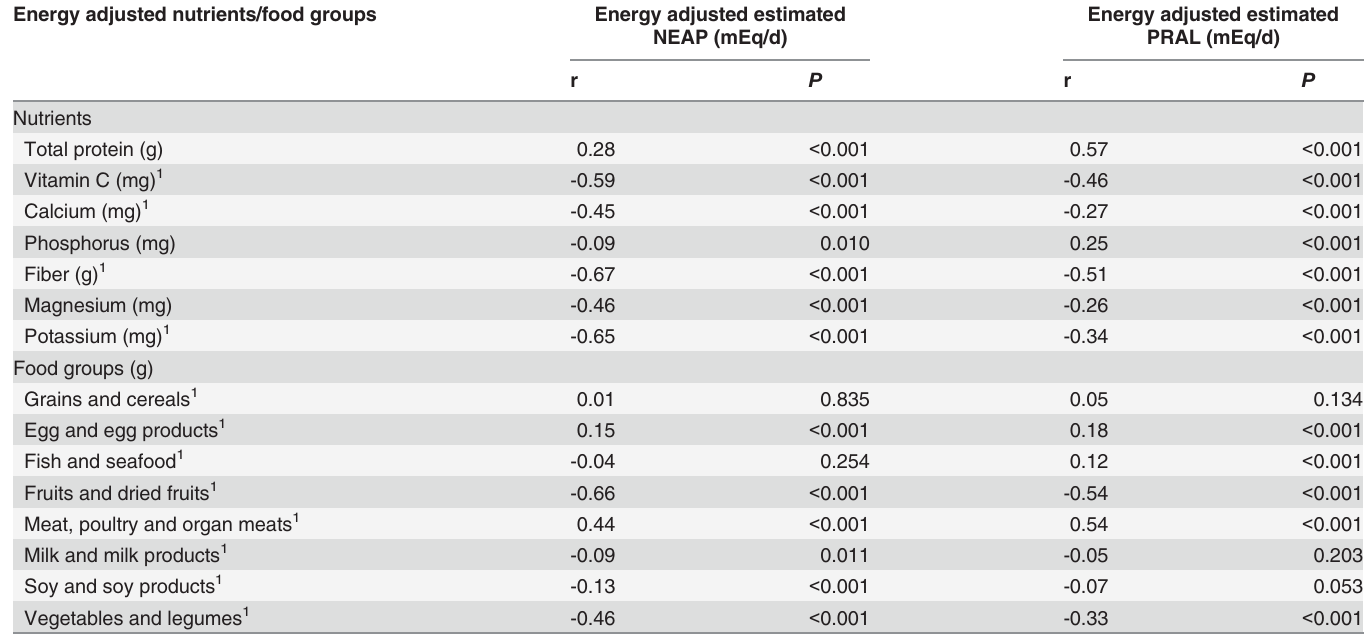
Table 3. Correlation between estimated NEAP or PRAL and selected nutrients and food groups (n = 793). Energy adjusted nutrients/food